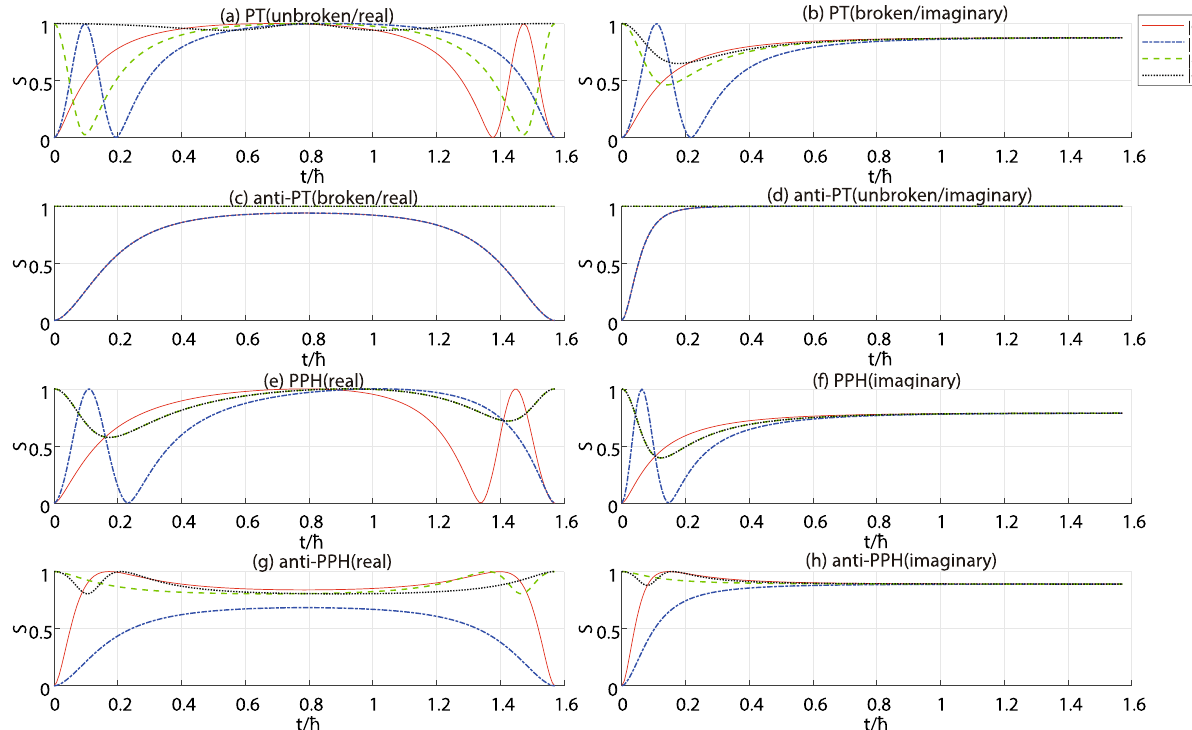
Figure 3. Entropy dynamics of NH systems with different input states. The computational bases are fixed as logic | 0 � and | 1 � . The red solid line, blue dashed-dotted line, green dashed line and black dotted line are related to the input states | 0 � , | 1 � , |+� and |−� , respectively. ( a ) The PT-symmetric system in PT-unbroken phase, or PT(real) phase; ( b ) The PT-symmetric system in PT-broken phase, or PT(imaginary) phase; ( c ) The anti-PT- symmetric system in PT-unbroken phase, or anti-PT(imaginary) phase; ( d ) The anti-PT-symmetric system in PT-broken phase, or anti-PT(real) phase; ( e ) The P-pseudo-Hermitian system with real eigenvalue-difference, or PPH(real) phase; ( f ) The P-pseudo-Hermitian system with imaginary eigenvalue-difference, or PPH(imaginary) phase; ( g ) The anti-P-pseudo-Hermitian system with real eigenvalue-difference, or anti-PPH(real) phase; ( h ) The anti-P-pseudo-Hermitian system with imaginary eigenvalue-difference, or anti-PPH(imaginary) phase. Notice that only one period is drawn in the subfigures ( a ), ( c ), ( e ) and ( g ), while no period in the subfigures ( b ), ( d ), ( f ) and ( h ). We set the same energy difference of the four systems in their real or imaginary phases,